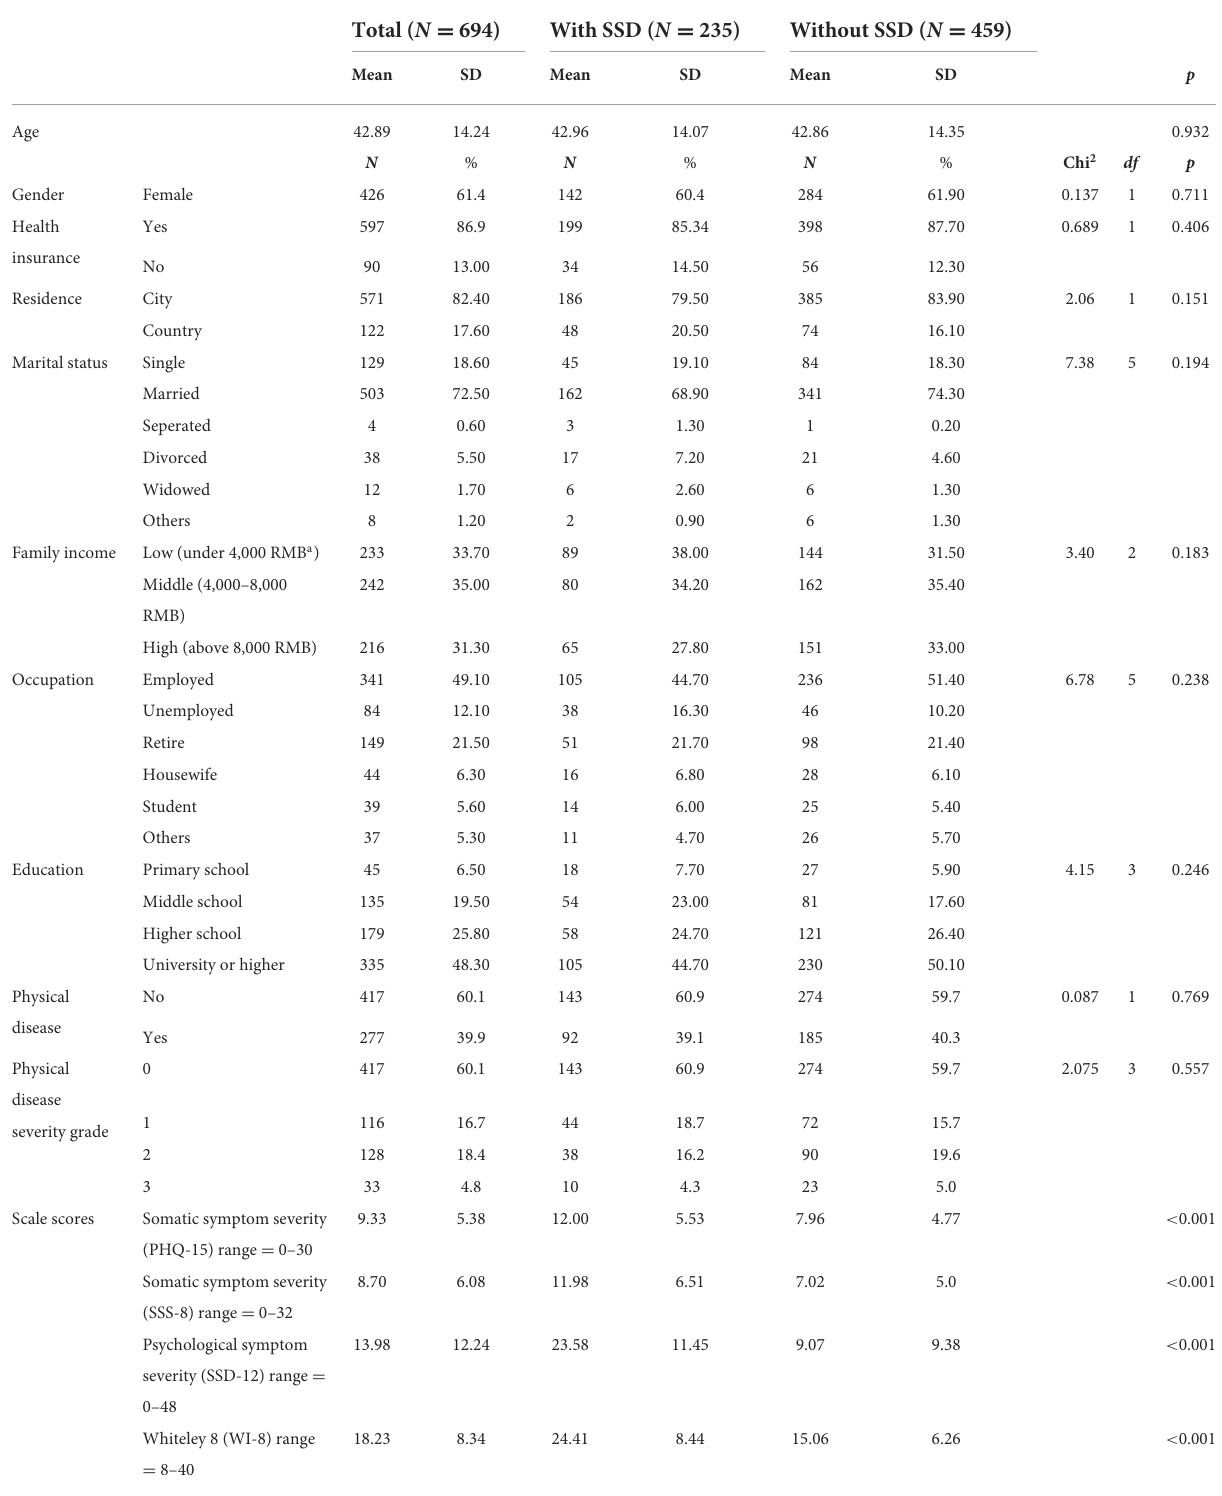
TABLE 1 Baseline data of the study sample ( N =